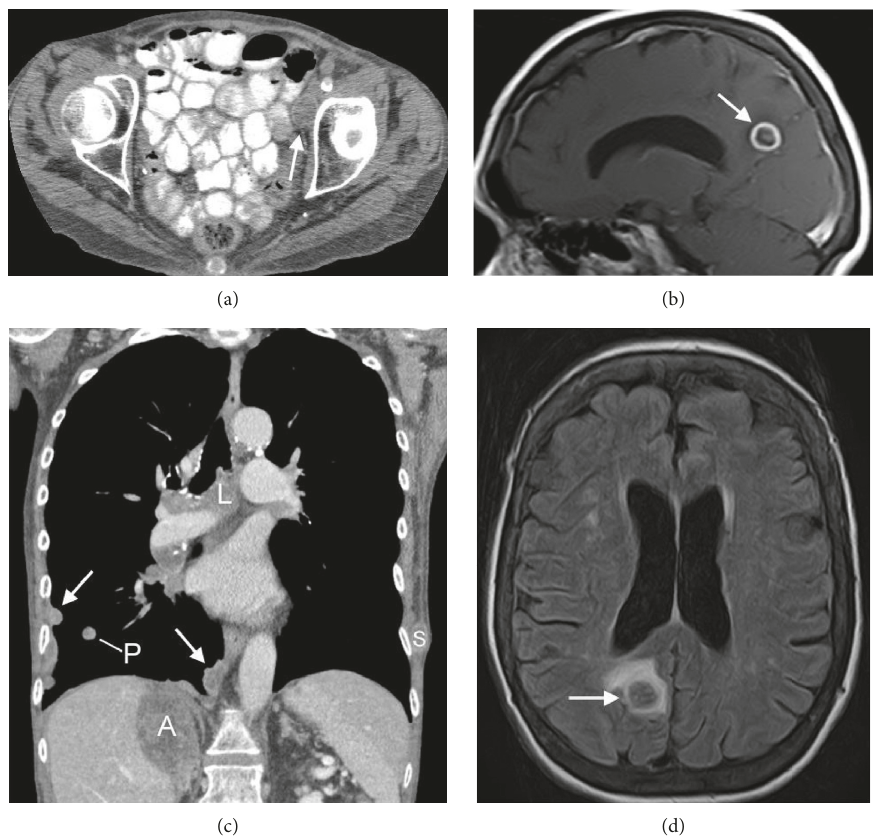
Figure 3: Progression of disease 18 months after starting capecitabine treatment. Axial postcontrast CTof the pelvis (a) shows increased size of a centrally necrotic left external chain lymph node, measuring 2.2 × 1.7 cm (white arrow). Postcontrast sagittal T1 MRI (b) and noncontrast coronal FLAIR MRI (d) of the brain show a new rim enhancing 1.2cm metastasis in the right posterior parietal lobe with surrounding edema (white arrows). Coronal postcontrast CT of the chest and abdomen (c) shows new right pleural metastasis (arrows), mediastinal and hilar lymph node (L), and left lateral chest wall soft tissue (S) metastases, as well as an enlarging right lower lobe pulmonary metastasis (P) and right adrenal metastasis superimposed on an existing adrenal adenoma